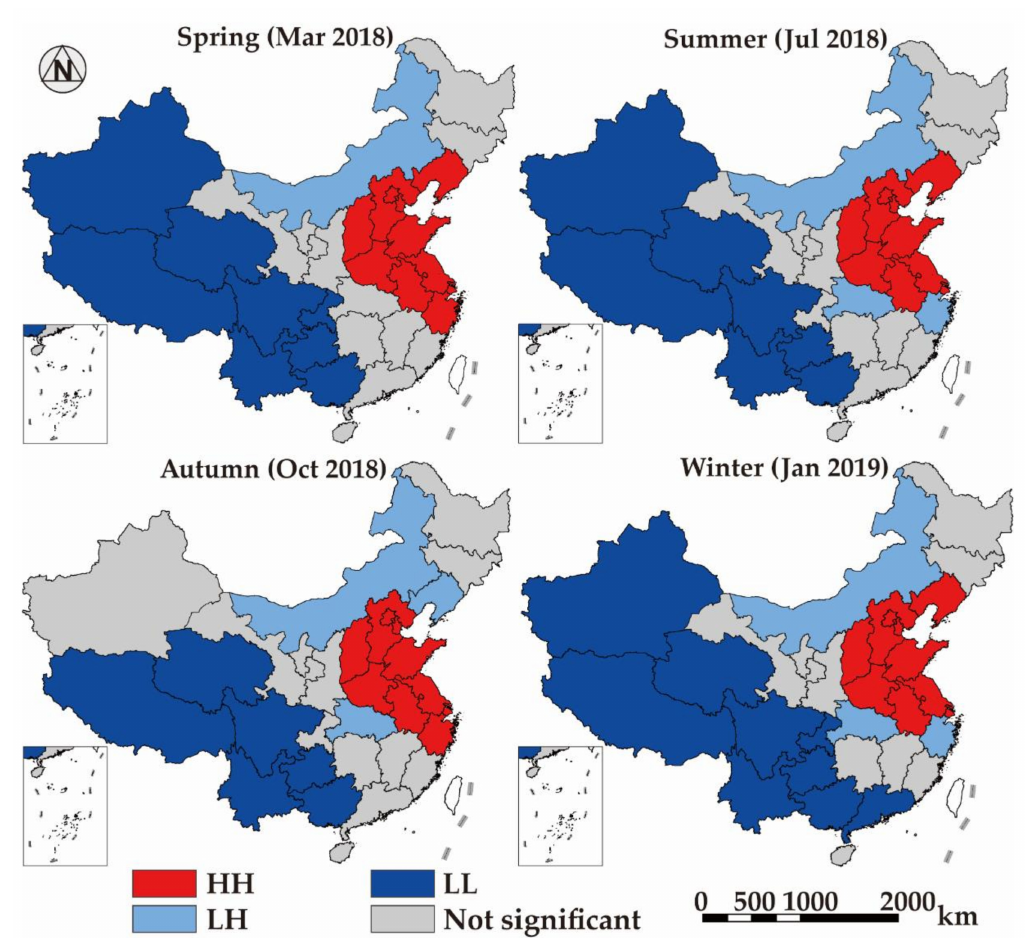
Figure 6. The Local Moran’s I results of provincial units in one month per